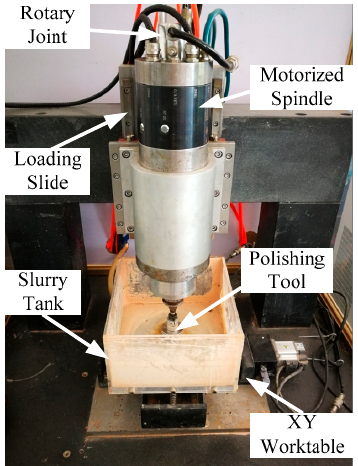
Figure 7. Experimental setup of disc hydrodynamic polishing DHDP.